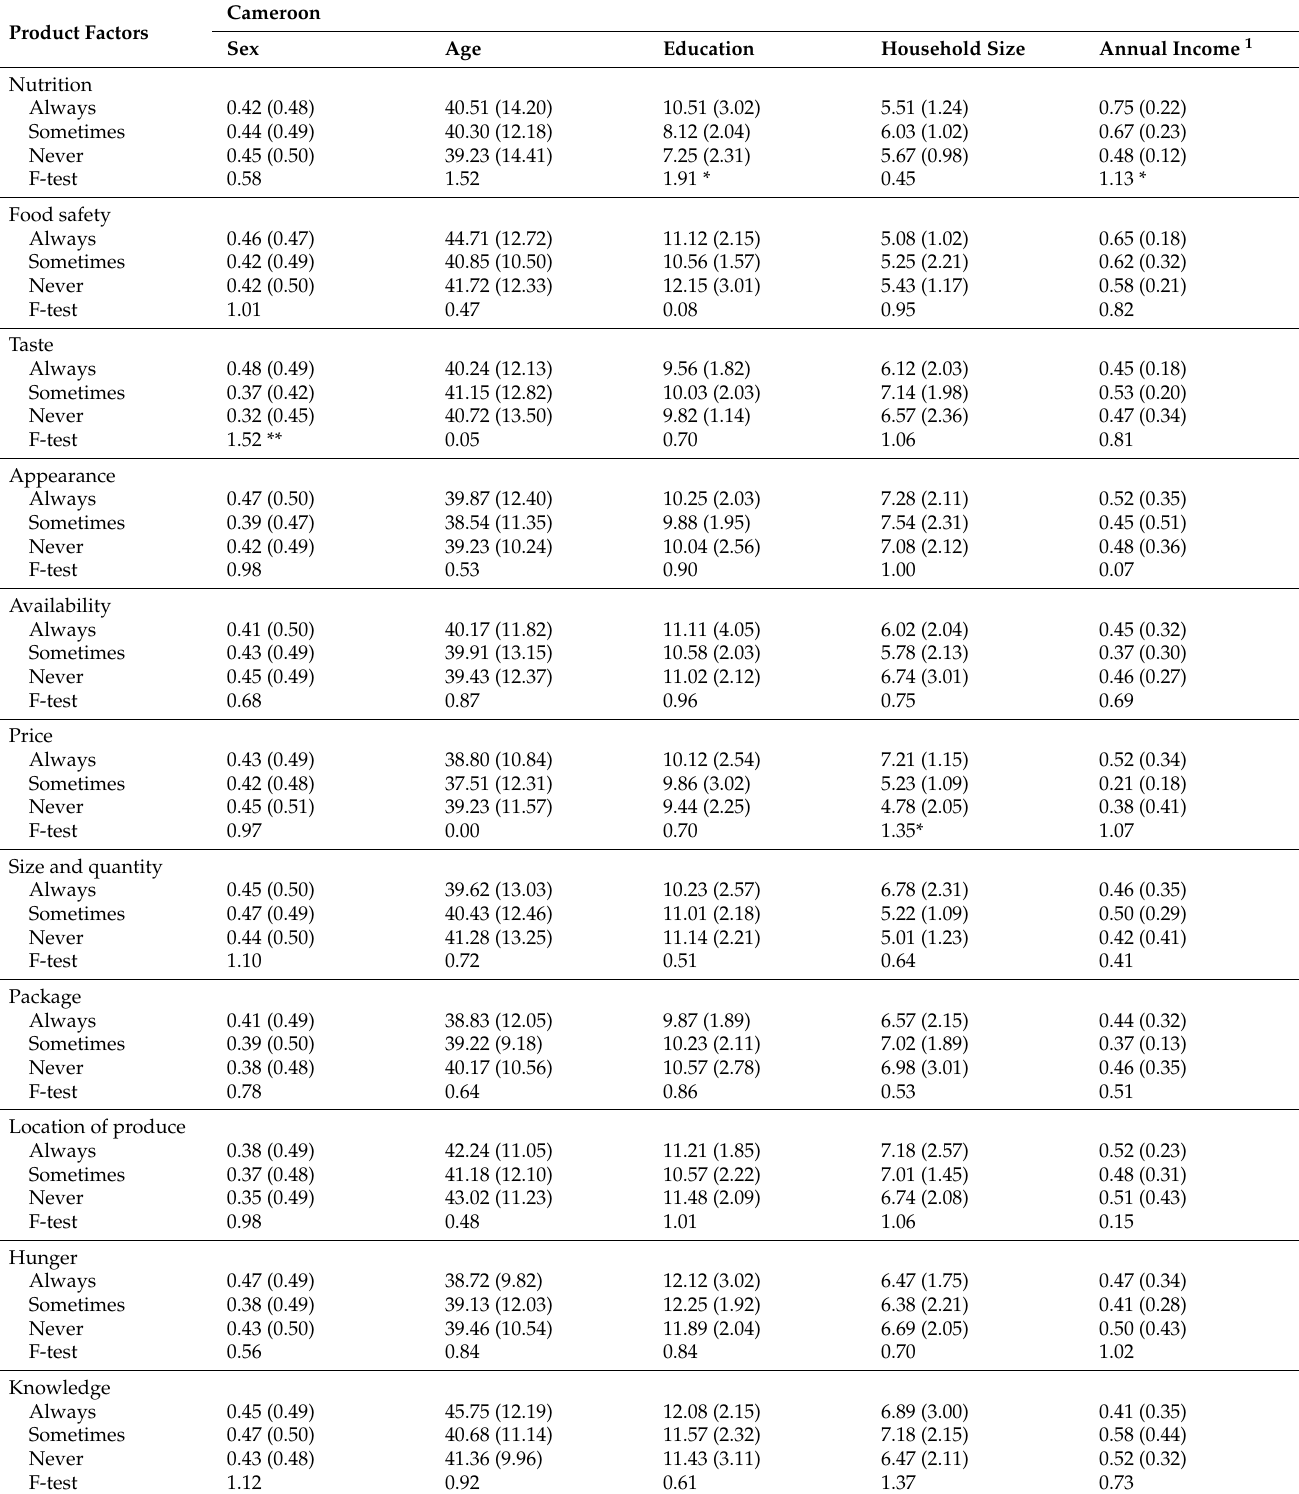
Table 4. Factors determining consumer’s choices for consumption of plantain-based products in